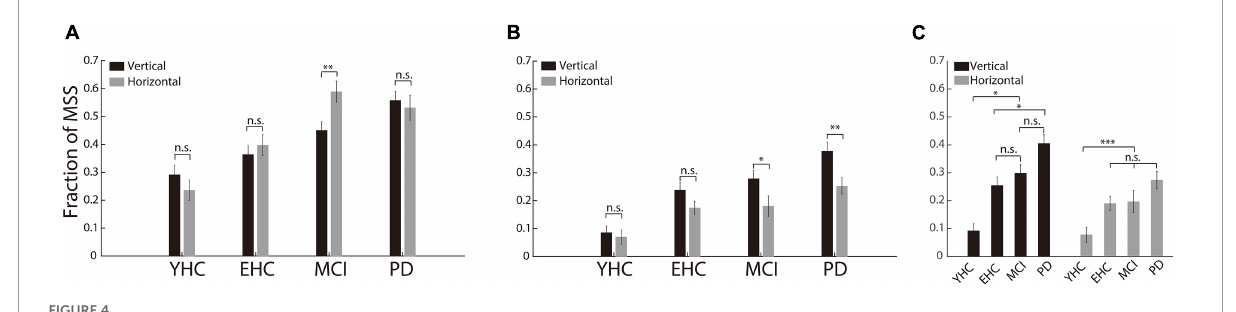
FIGURE4 The incidence of MSS in horizontal and vertical saccades. (A) The incidence of MSS combined with CS between horizontal and vertical saccades. There was no significant difference in MSS incidence between vertical and horizontal saccades in any of the four groups of participants. (B) The incidence of MSS between the horizontal and vertical saccades. There was a significant difference between the vertical and horizontal saccades in PD and MCI patients. (C) The comparison of the MSS incidence among the four groups of participants. The incidence of MSS in vertical saccades was significantly higher in PD than in YHC, EHC, and MCI participants. Error bars show the standard error of the mean; * p < 0.05, ** p < 0.01, *** p < 0.001, n.s., no significant difference (Wilcoxon rank-sum and sign-rank